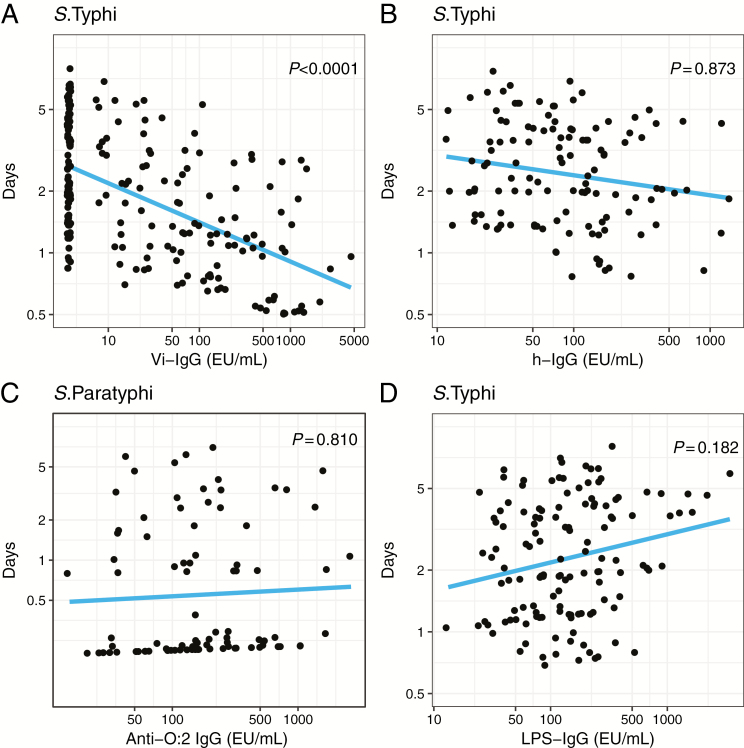
Relationship between days of bacterial shedding in stool after Salmonella Typhi or S. Paratyphi challenge and antibody levels prior to challenge. (A) Anti-Vi immunoglobulin (Ig) G prior to challenge with S. Typhi. (B) Anti-Hd IgG prior to challenge with S. Typhi. (C) Anti-O:2 IgG prior to challenge with S. Paratyphi. (D) Anti-S. Typhi lipopolysaccharide IgG prior to challenge with S. Typhi. Days: y-axis represents the predicted total number of days of stool shedding (out of 14). The total number of days was determined from the logistic regression model by summing across all 14 days the predicted probability for each day for each person. Abbreviation: Ig, immunoglobulin.